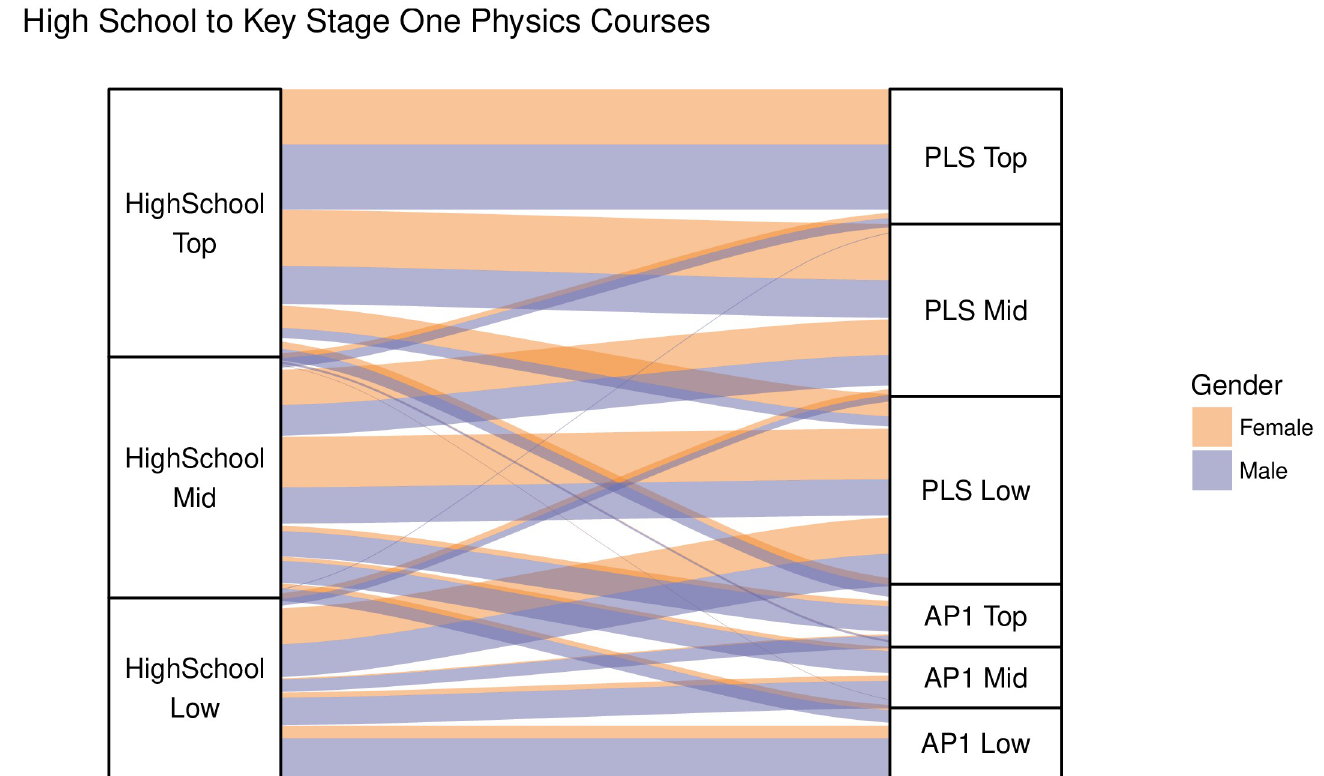
Fig 5. Student progression alluvial. An alluvial plot showing the progression of male (purple) and female (orange) students from high school to university physics split by achievement bands. Female students were equally represented among the top achieving high school group, but less well represented among the middle and low achieving groups. PLS (Physics for Life Sciences) and AP1 (Advancing Physics 1) represent the two main groups of physics students in our data. As shown in the alluvial plot, PLS was more popular than AP1, especially at the intersection of top achievers and female students.